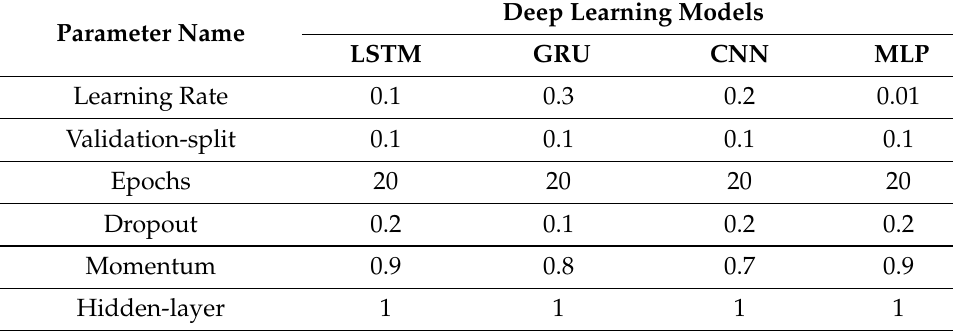
Table 2. Configuration